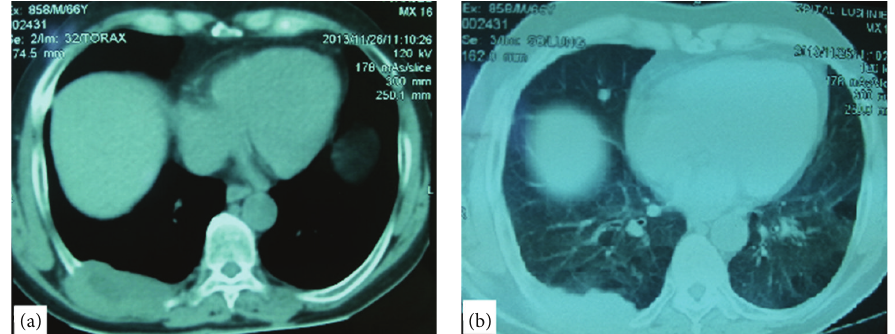
Figure 1: CT-scan. (a) Chest window that shows the tumor of thoracic wall. (b) Lung window that shows a node in the lower lobe of the right lung besides the tumor of thoracic wall.